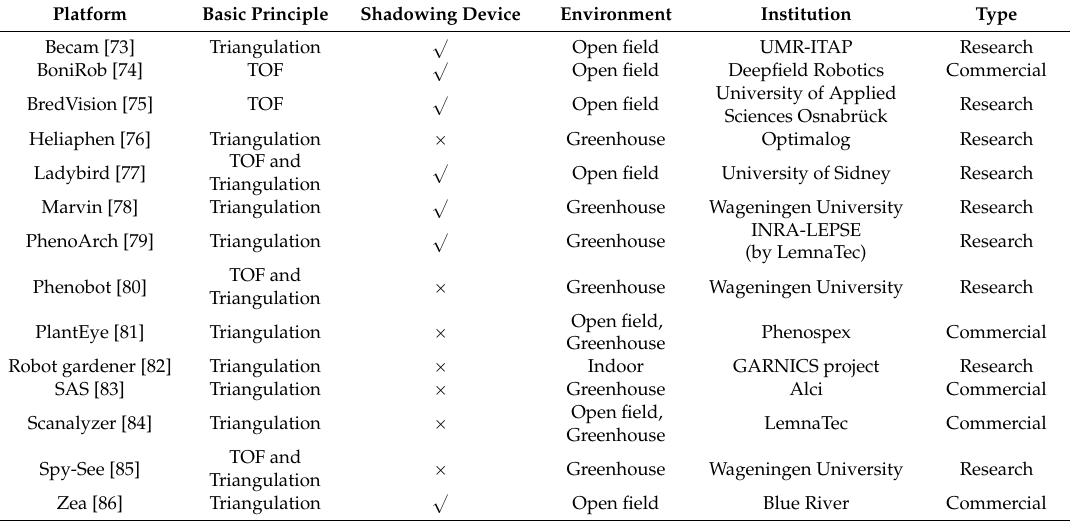
Table 1. Autonomous platforms for reducing the time-consuming and repetitive phenotyping practice.